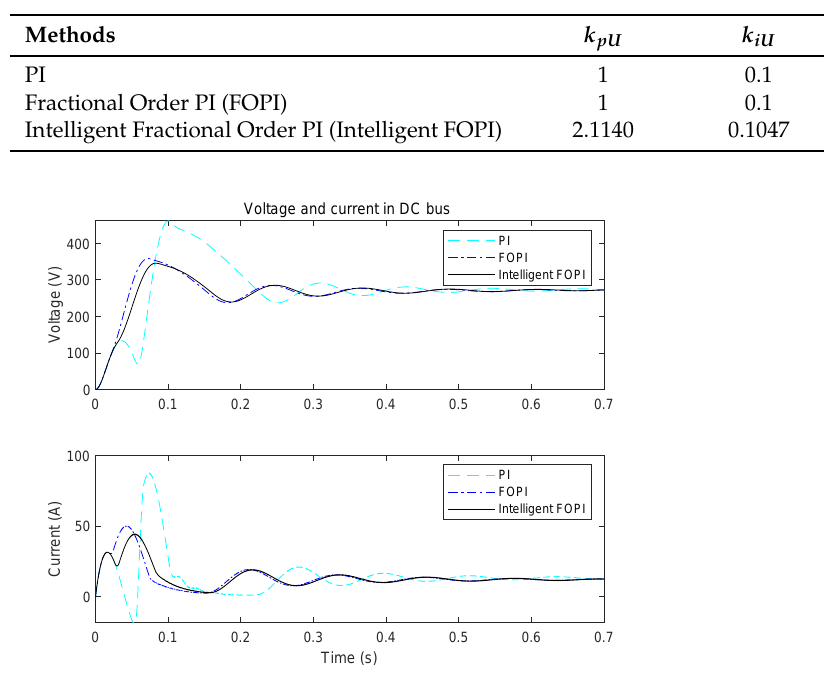
Table 3. Parameters in controllers for the voltage outer loop of APF-ATRU.